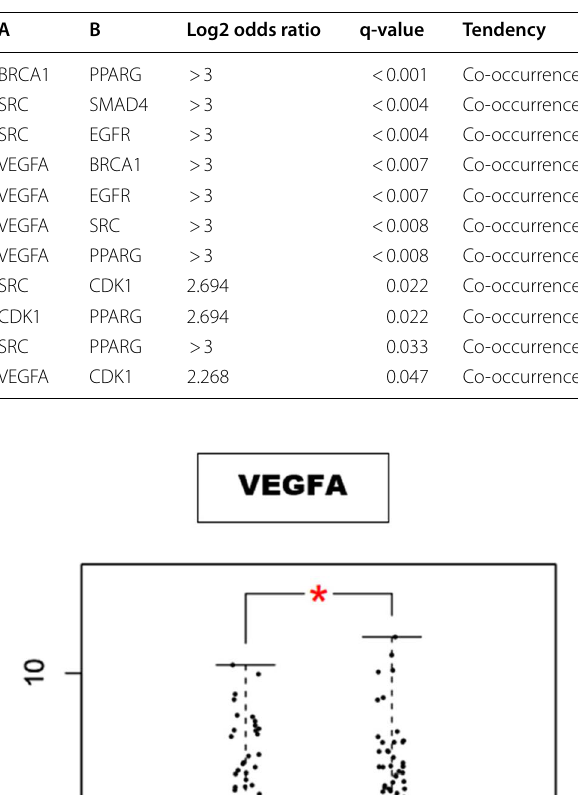
Table 2 The results of the mutual exclusivity analysis of the hub genes